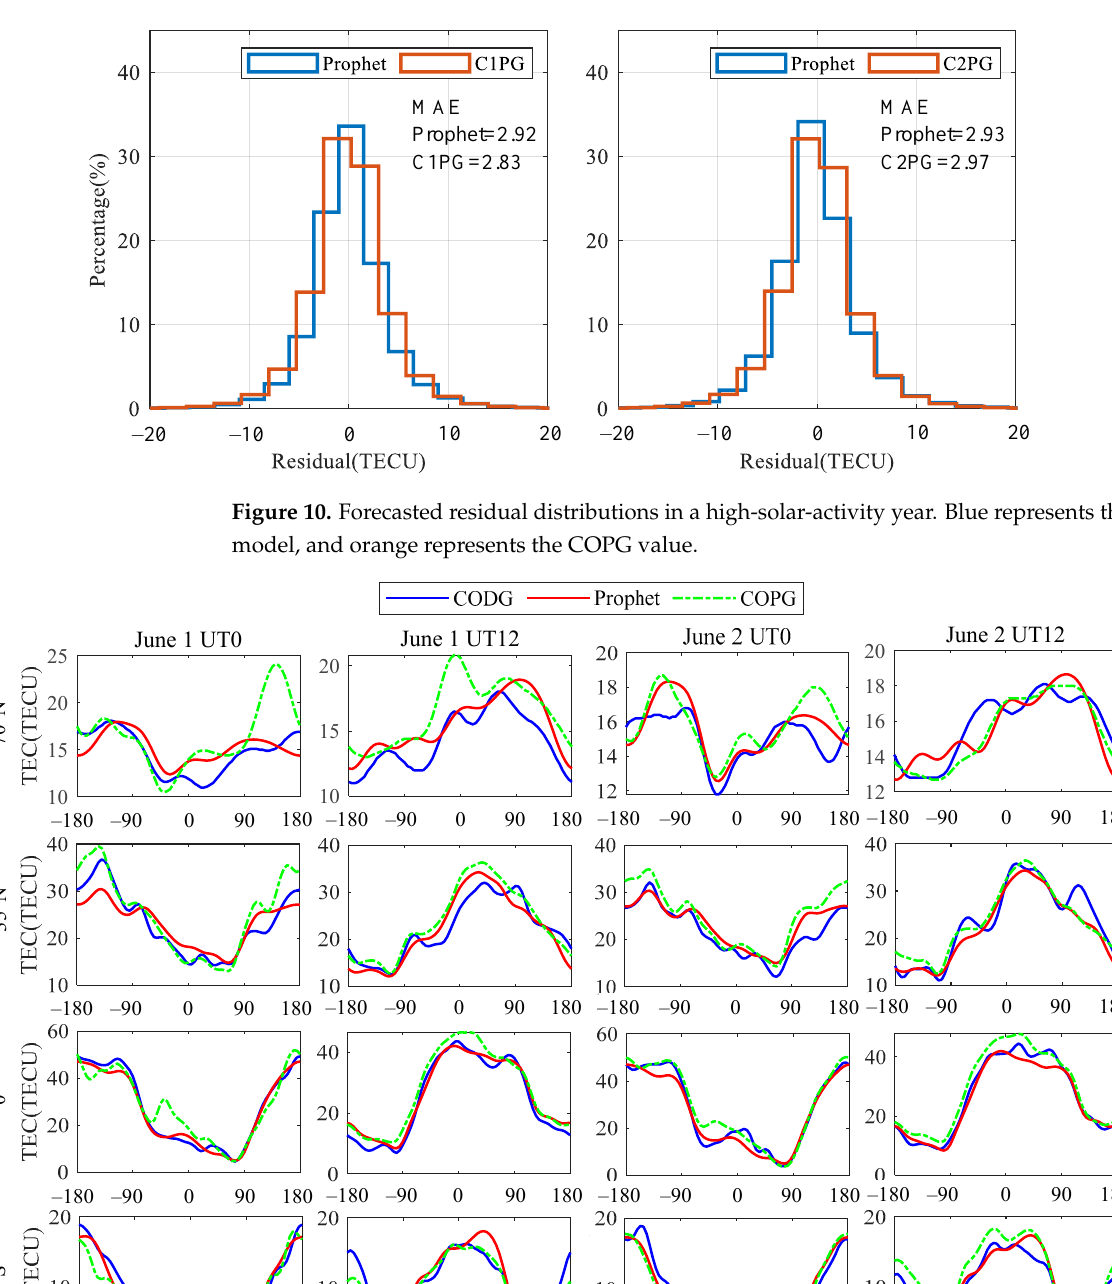
Figure 9. Correlation analysis between forecasted values and CODG values on 2 June in a year of high solar activity. ( a – c ) Scatter density plots of the correlations between the 7-day, 15-day and 30- day Prophet model forecasted values, respectively, and the CODG values. ( d ) Scattered density plot of the correlation between the COPG and CODG values.